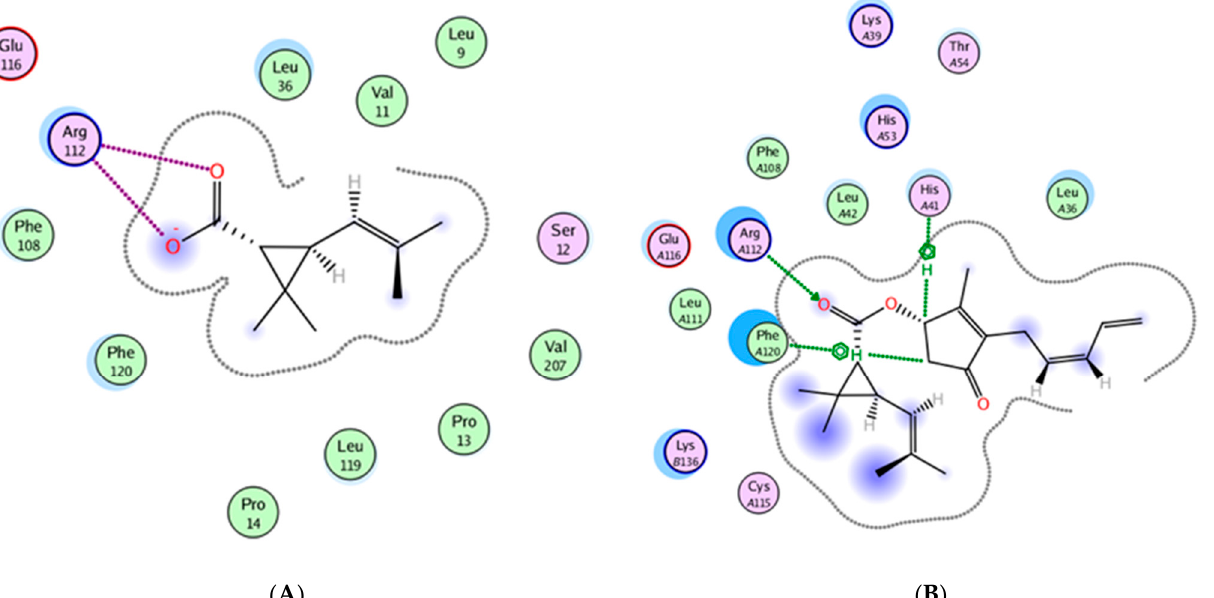
Figure 3. Two-dimensional interaction images of docking conformations of trans -chrysanthemic acid and pyrethrin with the active proteins: ( A ) interaction trans -chrysanthemic acid and protein 5FT3; ( B ) interactions pyrethrin and protein 5FT3.